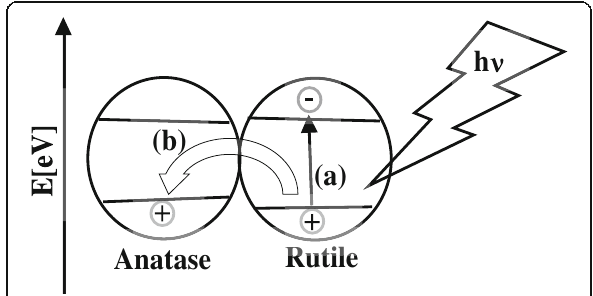
Fig. 9 Plausible model of a generation of electron-hole pairs and b effective charge carrier separation via transfer of the generated holes into the anatase valence